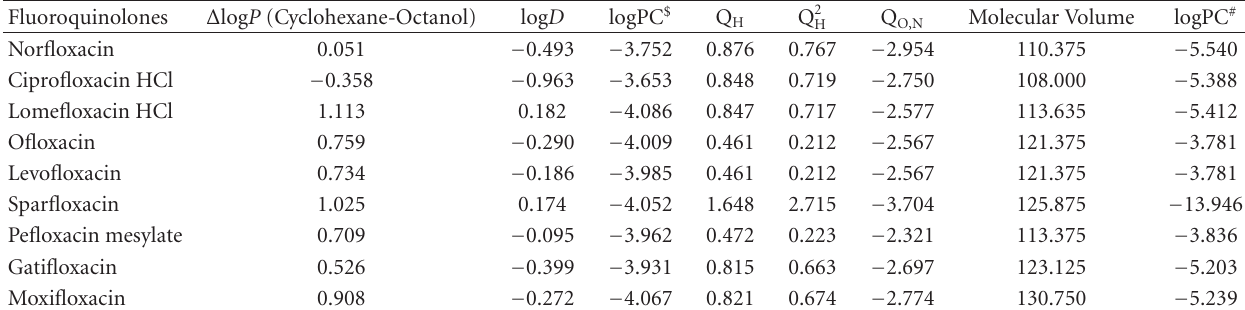
Table 4: Determination of various molecular descriptors used in Model 1, and 2 along with permeability coe ffi cient (logPC) derived using algorithms (1) and (3) for all fluoroquinolones.